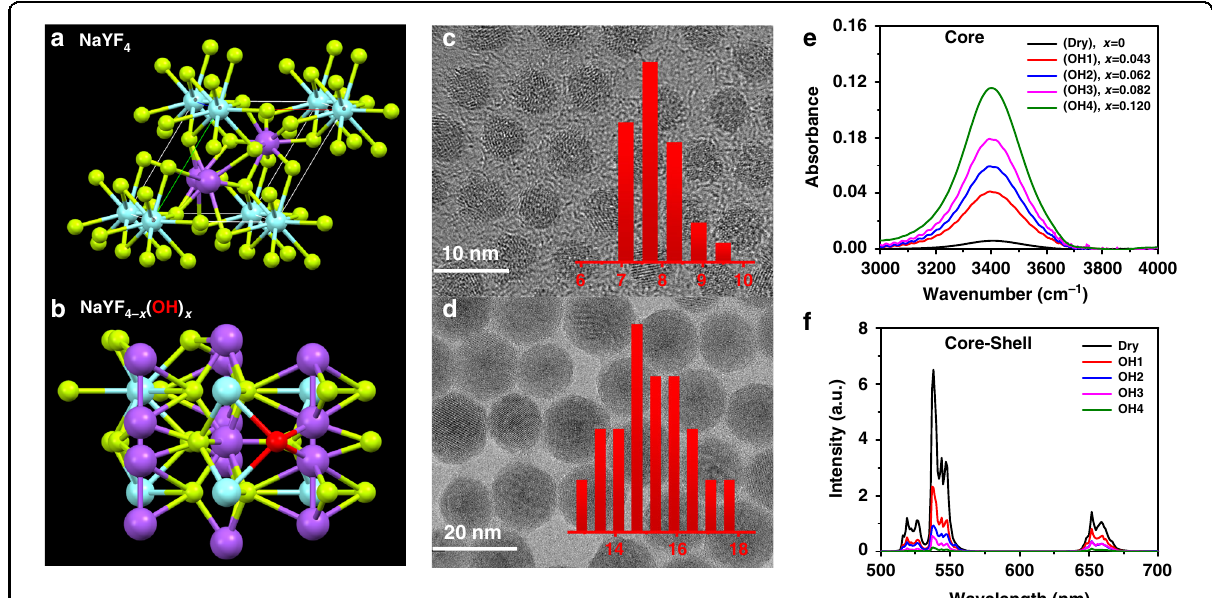
Fig. 1 Schematic illustration and characterization of OH − involved UCNPs. Schematic illustration of a NaYF 4 and b NaYF 4- x (OH) x structures in a unit cell with OH − marked as red ball, Na + as blue ball, Y 3 + as purple ball, and F − as yellow ball. Typical TEM images of c dry core (NaYF 4 :Yb,Er) and d dry core-shell (NaYF 4 :Yb,Er@NaYF 4 ) UCNPs. Inset: the diameter distribution of the synthesized particles. e FTIR spectra of core UCNPs (NaYF 4- x (OH) x : Yb,Er) containing different amounts of OH − ( x varies from 0 to 0.120). f UCL spectra of the corresponding core-shell UCNPs (NaYF 4- x (OH) x :Yb, Er@NaYF 4 ) in n -hexane with 980 nm laser excitation under power density of 10 W cm −